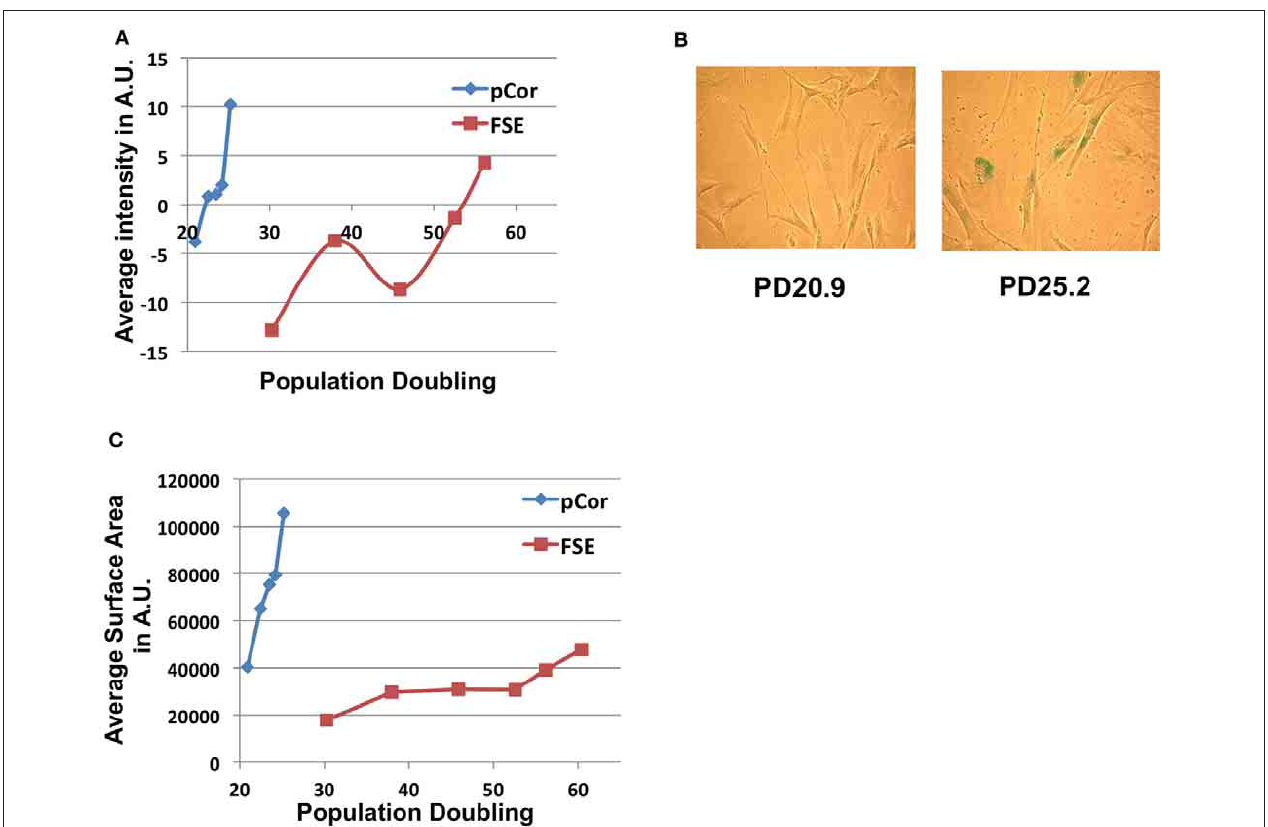
FIGURE 3 | ICF fibroblasts display high levels of SA- β -Gal staining and large cell surface at a relatively low population doubling. (A) SA- β -Gal assay was performed on FSE and pCor fibroblasts at different PDs and the average blue staining intensity was determined by quantitative software, as described (Shlush et al., 2011). The average